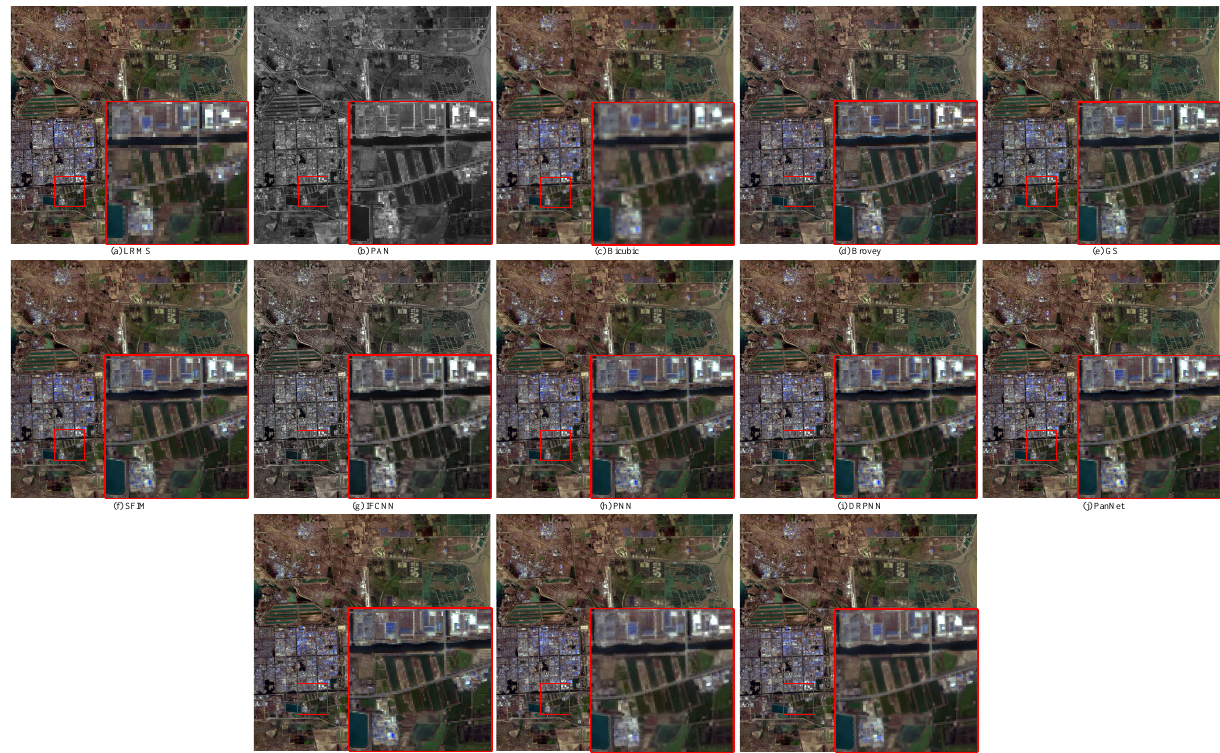
Figure 14. Subjective comparison between RDFNet and the current mainstream fusion methods for testing dataset fusion results of Landsat-8 with reduced resolution. ( a ) LRMS; ( b ) PAN; ( c ) Bicubic; ( d ) Brovey; ( e ) GS; ( f ) SFIM; ( g ) IFCNN;